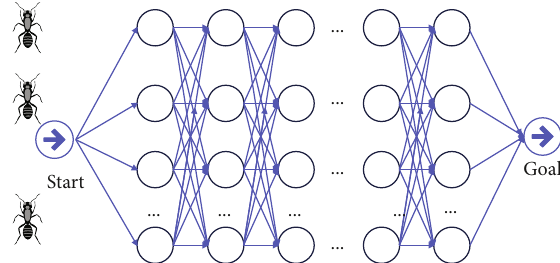
Figure 6: Traditional optimization diagram.